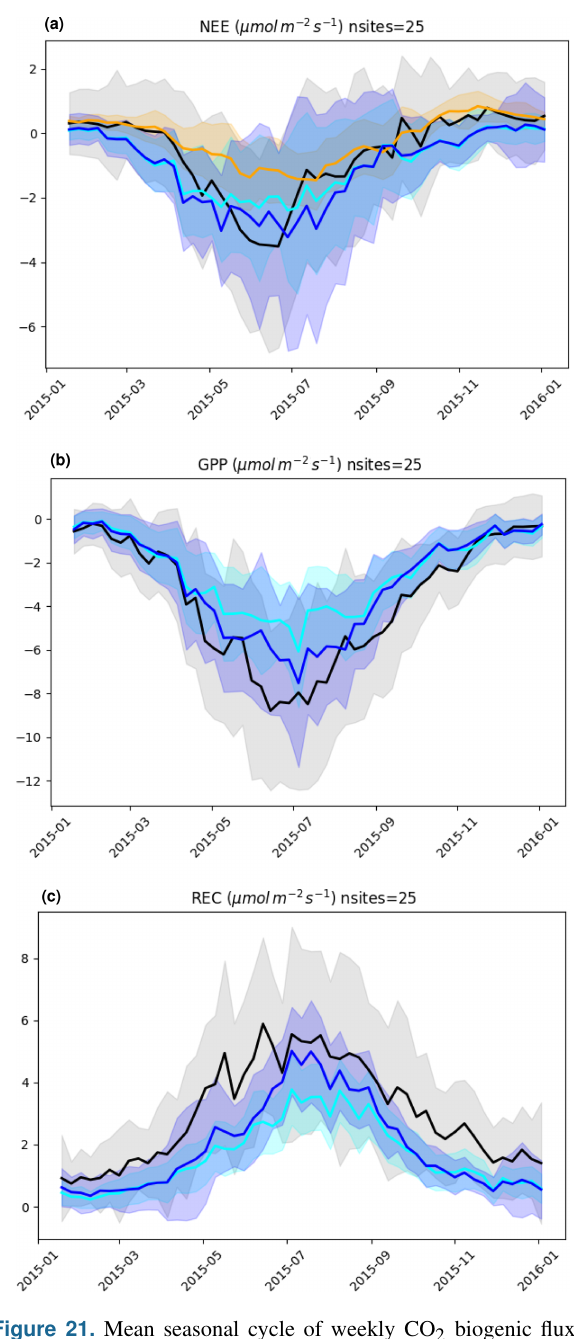
Figure 21. Mean seasonal cycle of weekly CO 2 biogenic fluxes µmol [m − 2 s − 1 ] from ERA5-Land (in cyan), bias-corrected ERA5- Land (in blue), and the CAMS atmospheric in situ inversion product (v18r3, https://atmosphere.copernicus.eu/data, last access: 27 Au- gust 2021, Chevallier et al., 2010) minus fossil fuel emissions (in or- ange) for 2015 at 25 ICOS-ETC sites over Europe (in black) (ICOS- ETC Drought 2018 Team, 2019). The shading shows the standard deviation of each dataset across the 25 sites. (a) NEE; (b) GPP; (c) ecosystem respiration ( R eco